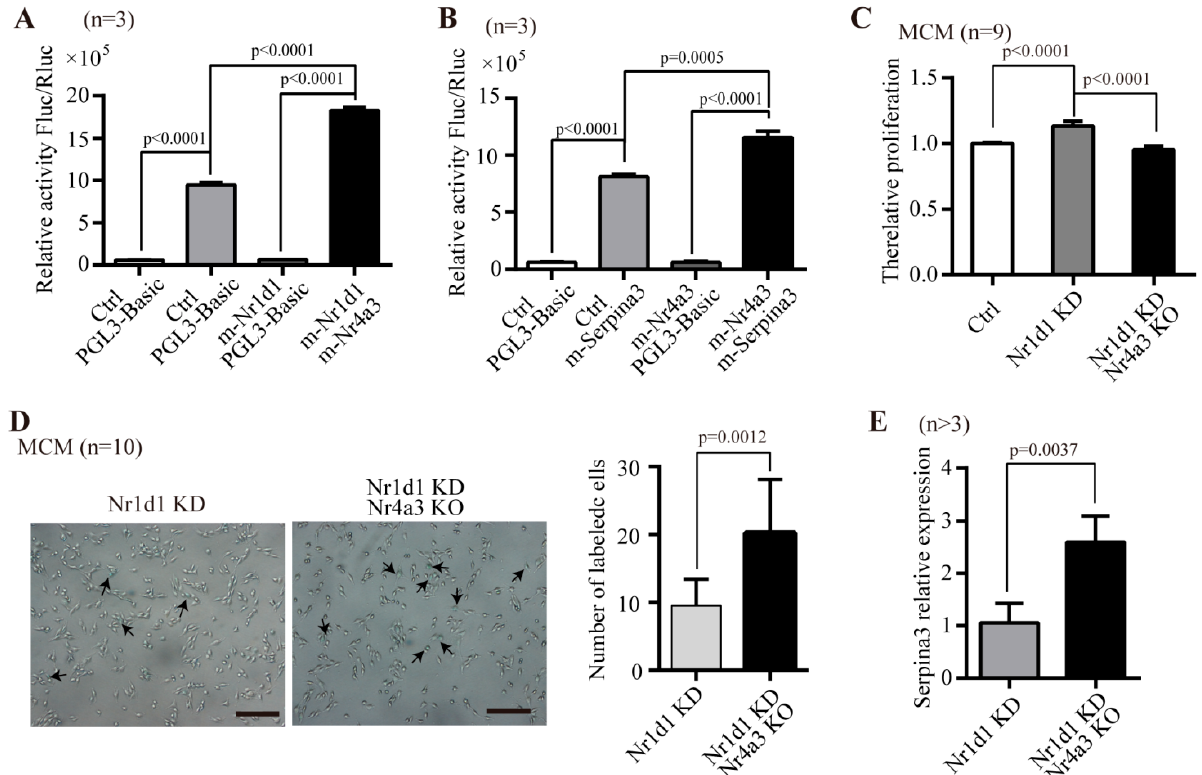
Figure 7. Regulatory mechanism of Nr1d1 . ( A , B ) effect of Nr4a3 and Serpina3 on transcription of Nr1d1 assessed by a Dual-Luciferase reporter system. MCM cells were transfected with Nr4a3 luciferase reporter plasmid for 24 h, and incubated with or without the Nr1d1 plasmid ( A ) or MCM cells were transfected with Serpina3 luciferase reporter plasmid for 24 h, and incubated with or without the Nr4a3 plasmid ( B ). Cells were lysed with lysis buffer, and the lysates were subjected to the luciferase activity assay, data were collected from three independent experiments ( n = 3), two-way ANOVA was applied for statistical analysis, and p < 0.05 was considered